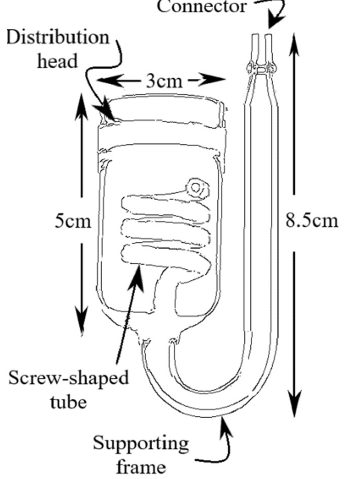
Processes 2020 , 8 , x